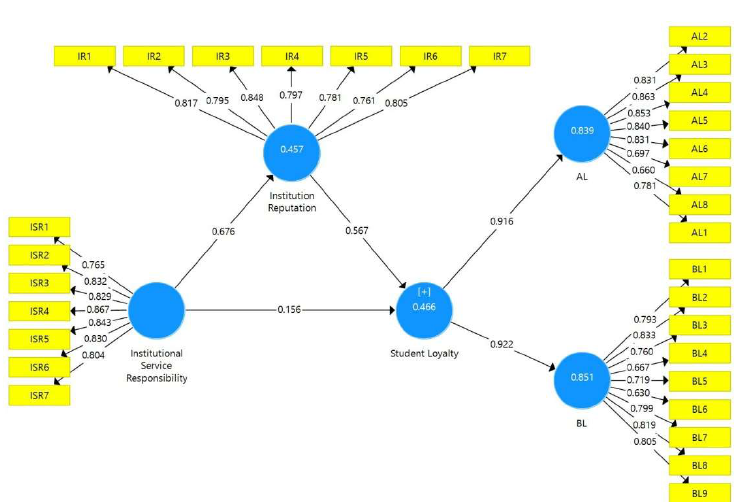
Fig. 2. Measurement